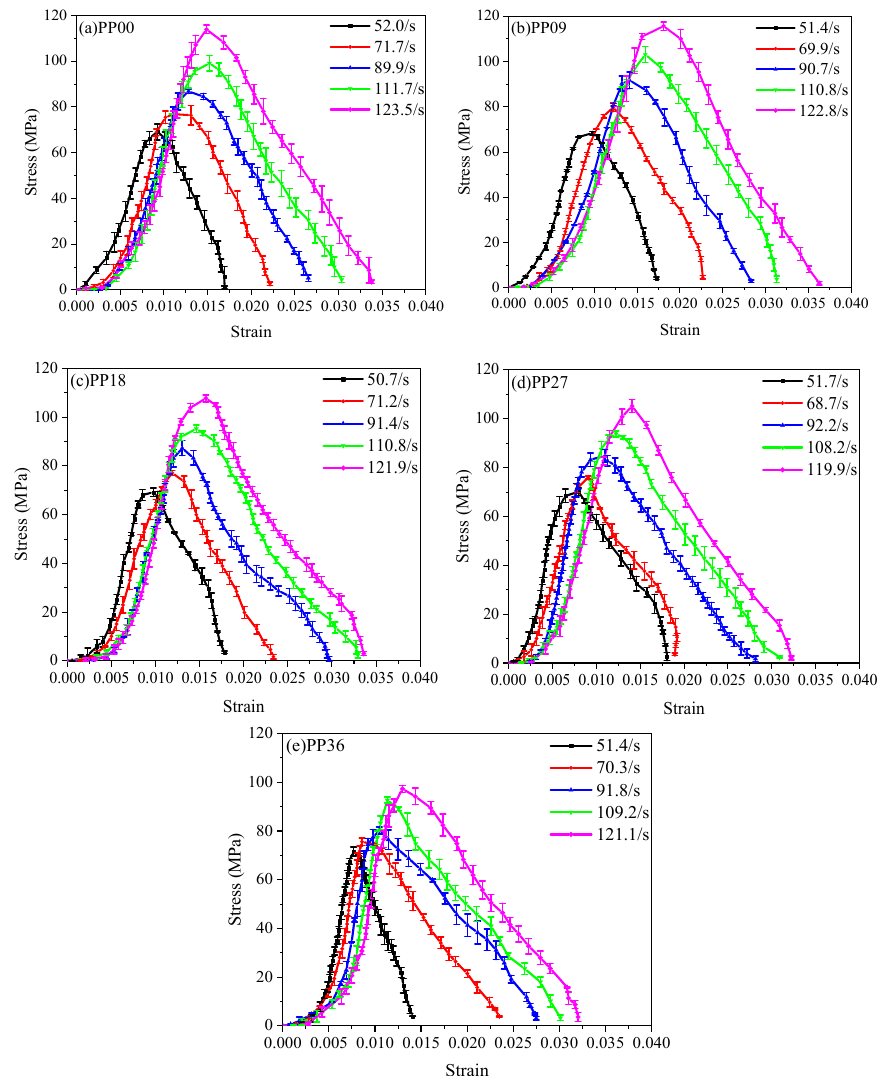
Figure 7. Effect of strain rate on dynamic compressive stress-strain relationship of ( a )PP00; ( b )PP09; Figure 7. E ff ect of strain rate on dynamic compressive stress-strain relationship of ( a ) PP00; ( b ) PP09; ( c )PP18; ( d )PP27; ( e )PP36. ( c ) PP18; ( d ) PP27; ( e )